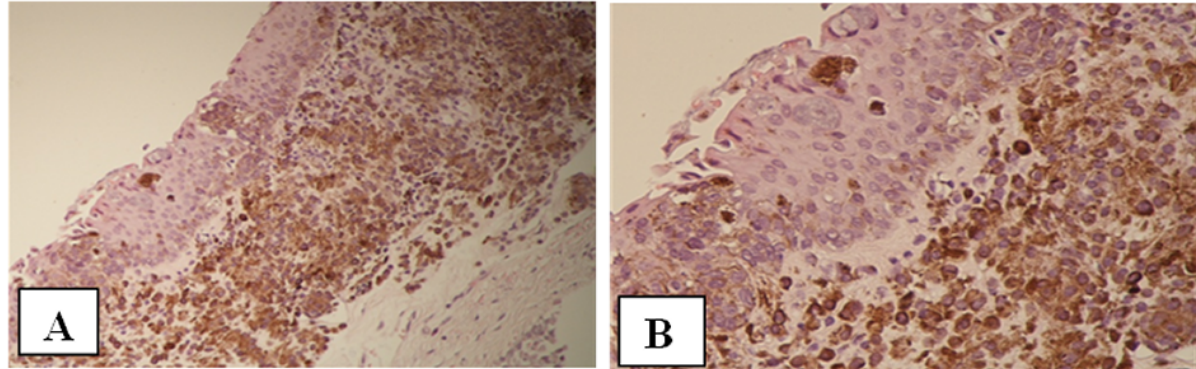
Figure 4: Fragment of lesion where it’s possible to recognize pigmented tumoral mass (A). Higher magnification of the image preceding: the superficial layers of the epithelium of the conjunctiva are infiltrated by atypical melanocytes (B).